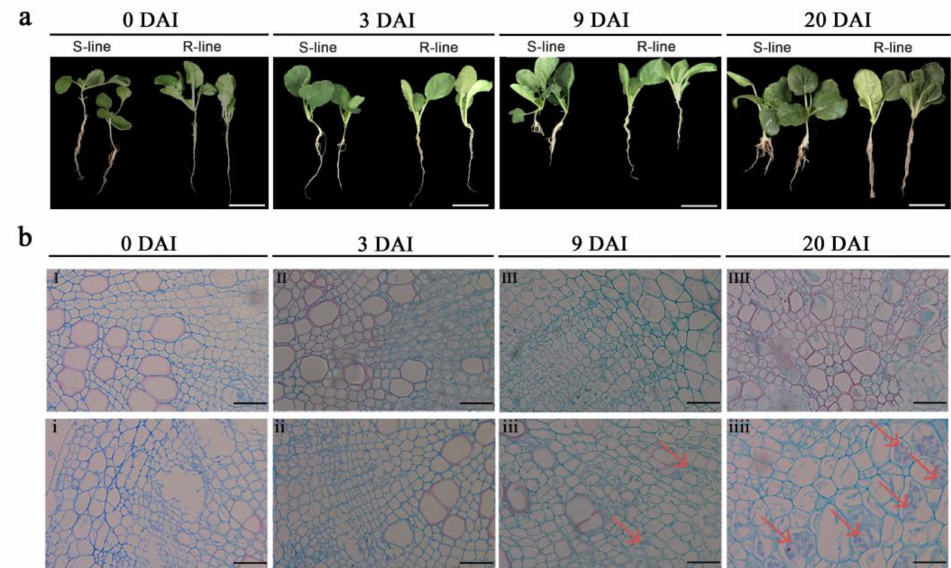
Figure 1. ( a ) Representative images of S- and R-line material at 0, 3, 9, and 20 DAI (days after inoculation) of P. brassicae. Bar = 5 cm. ( b ) Cross sections (4 µ m thick) of paraffin embedded roots of the R-line (I–IIII) and S-line (i–iiii) at 0, 3, 9, and 20 DAI, respectively. Bar = 50 µ m. The red arrow points to abnormal cells after clubroot